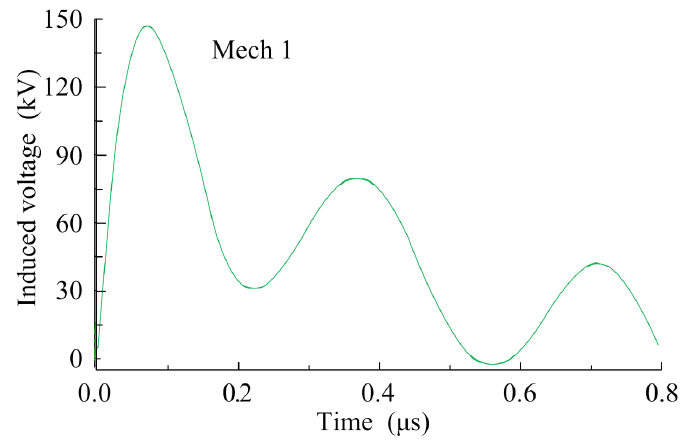
Figure 16. Induced voltage in mesh 1 under − 1/200 µ s and 50